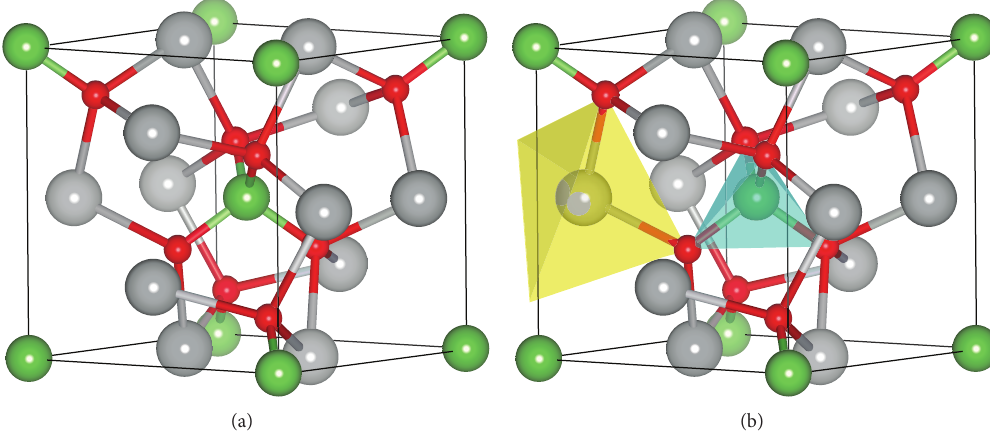
Figure 1: Crystal structure of Ag 3 AsO 4 with P4-3n space group (a) ball and stick and (b) polyhedron configurations. Red, green, and gray spheres represent O, As, and Ag atoms. AgO 4 and AsO 4 tetrahedral units are indicated by the yellow and blue tetrahedrons, respectively.